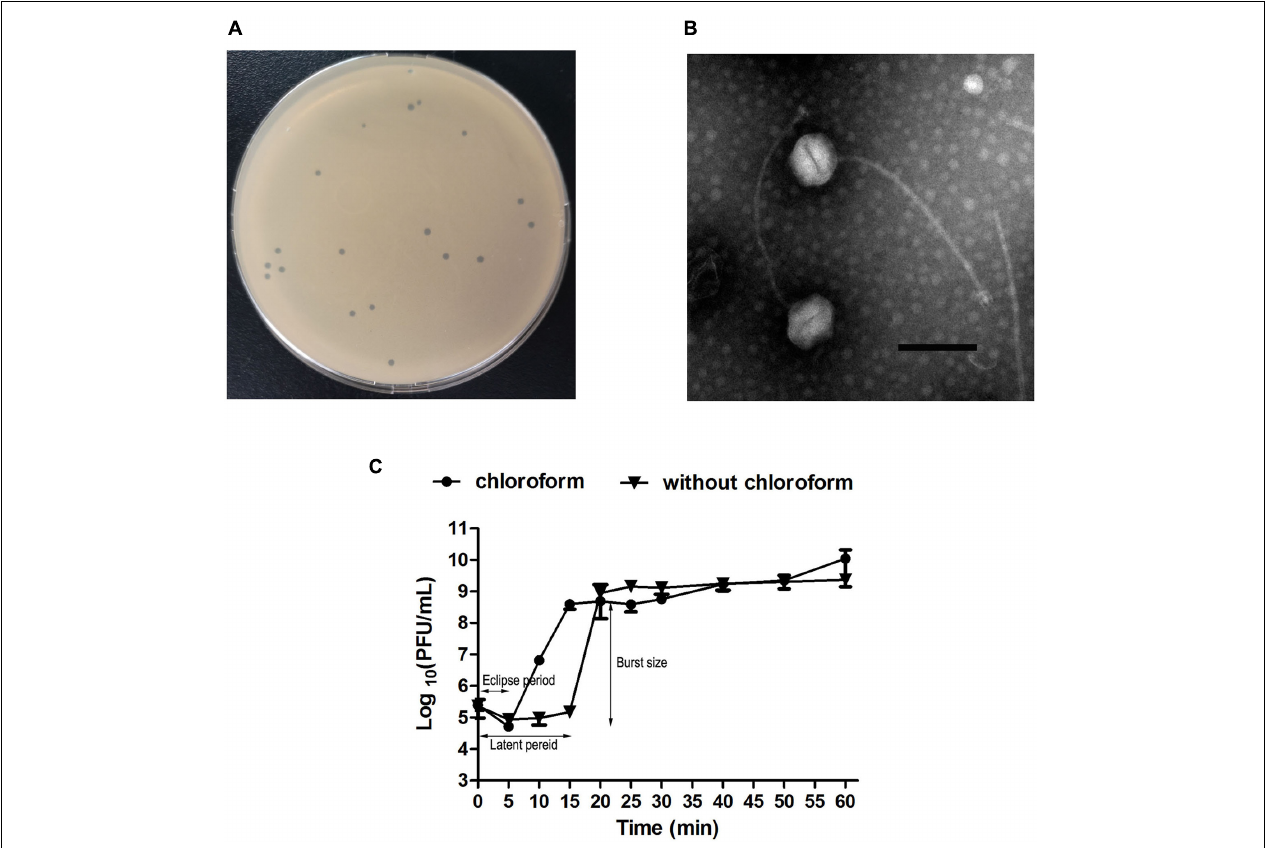
FIGURE 1 | Characteristics of phage vB-ApyS-JF1 (JF1). (A) Plaques formed by JF1. (B) Phage JF1 was negatively stained with 2% phosphotungstic acid (PTA) and examined using transmission electron microscopy (TEM) at an accelerating voltage of 80 kV. The scale bar represents 100 nm. (C) One-step growth curve